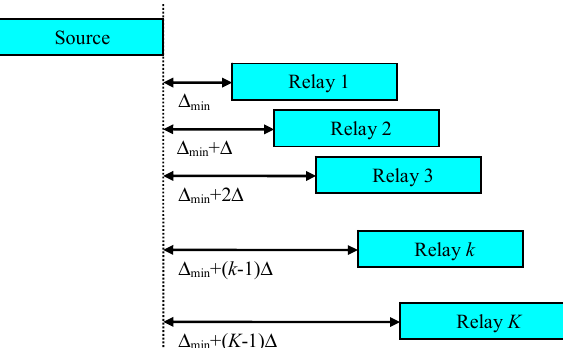
Figure 6. Listen-before-talk (LBT) with different delays.